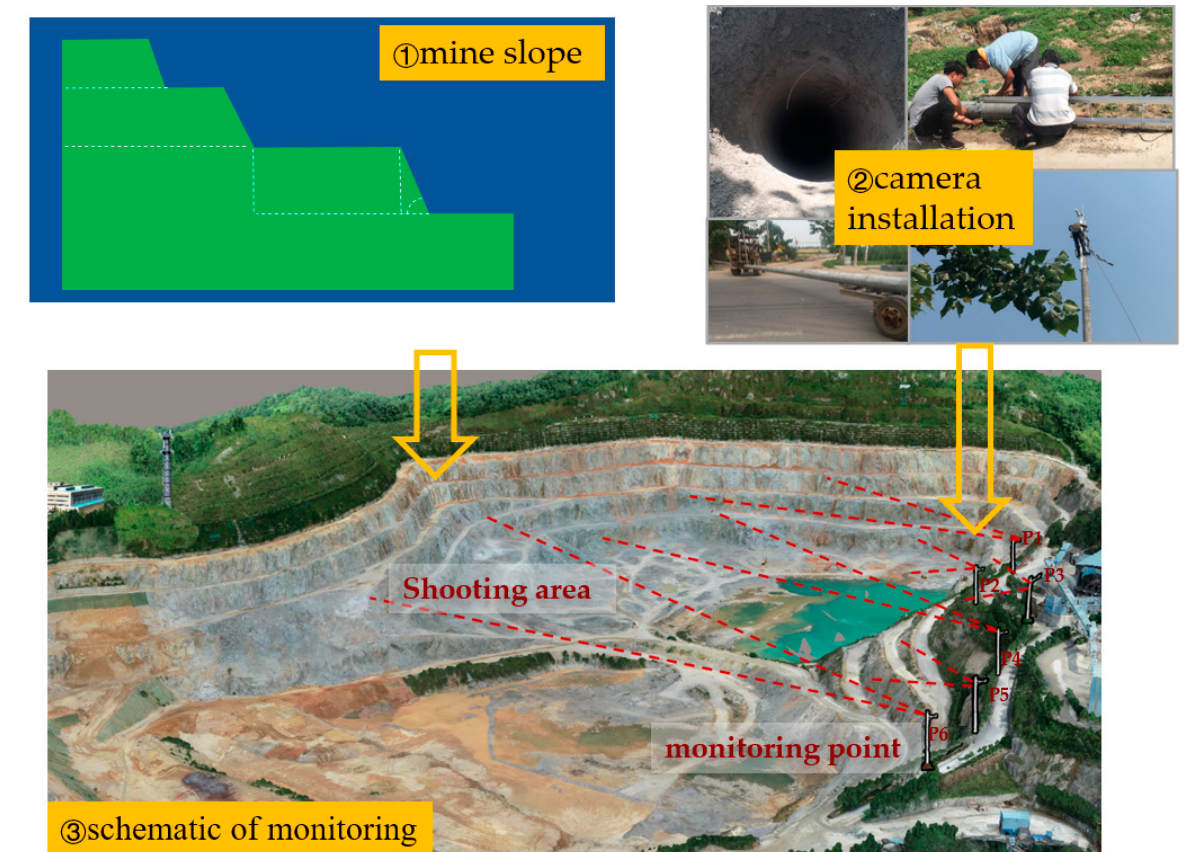
Figure 13. Schematic diagram of the camera field deployment. ① Schematic view of the slope of the mine. ② Pictures of the field installation, including pole tower transportation, drilling and camera installation, etc. ③ Schematic view of the Shunxing Quarry monitoring.